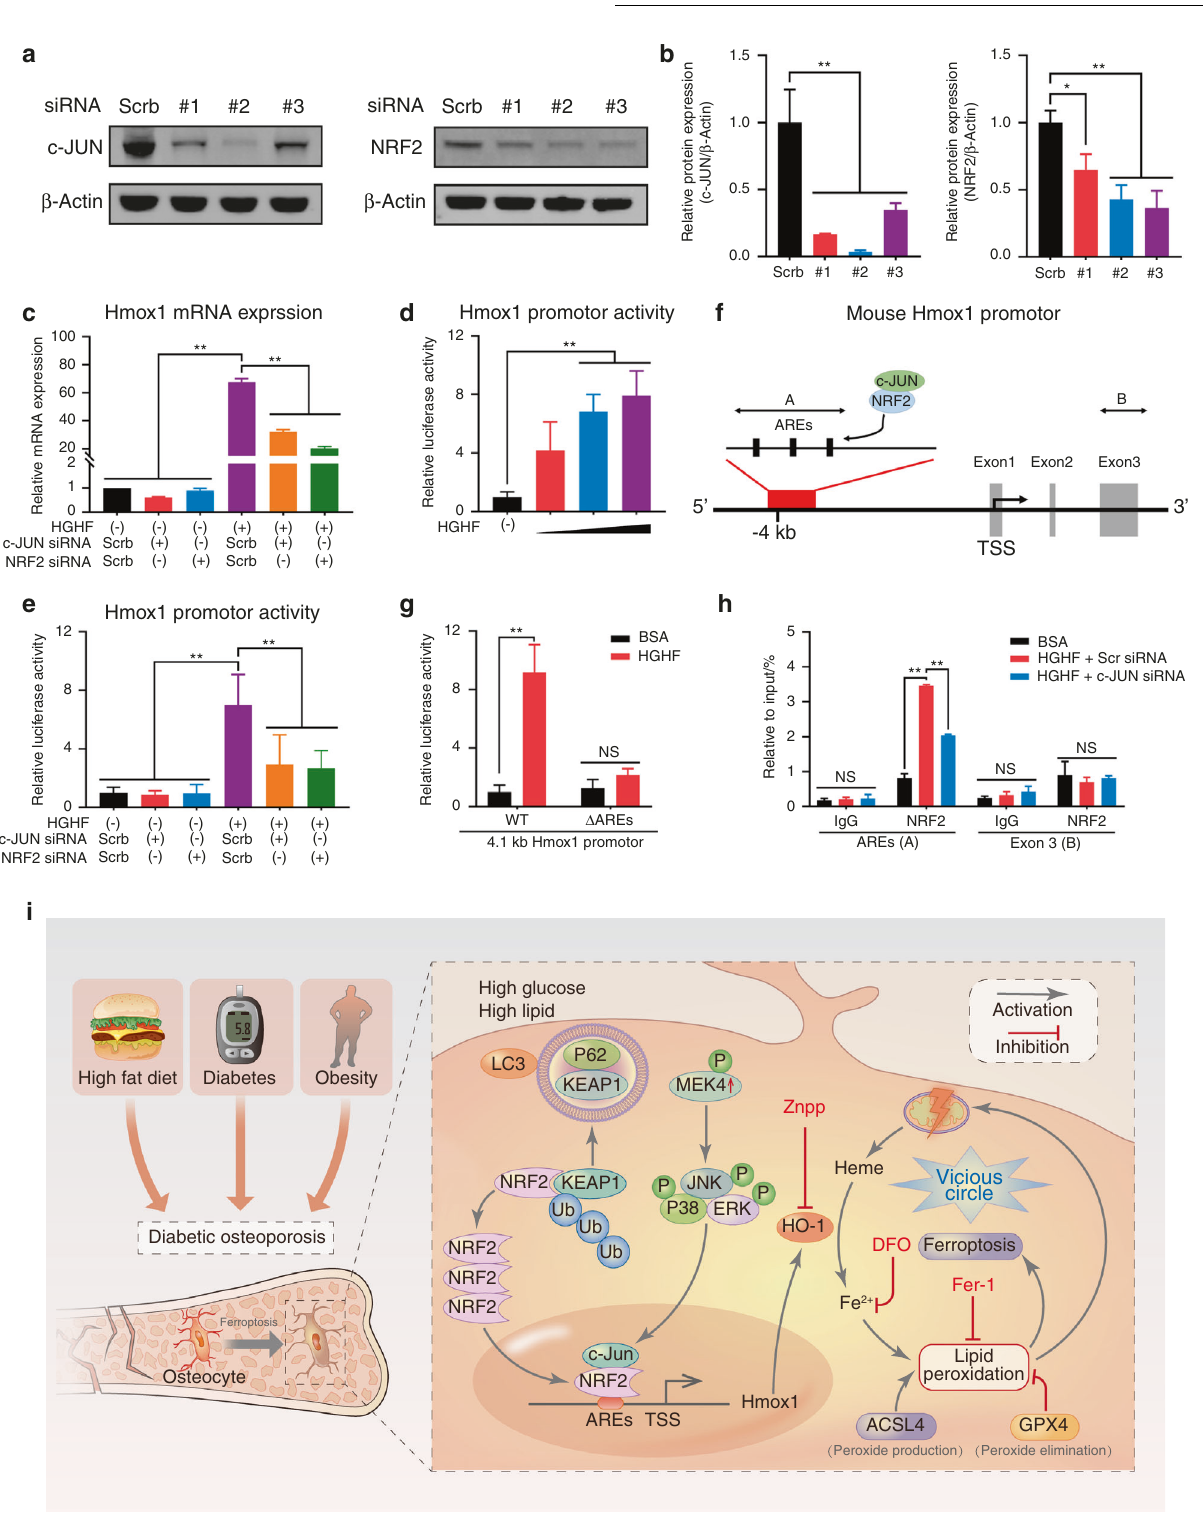
Fig. 6 HGHF-induced HO-1 expression was dependent on the NRF2 – c-JUN interaction. HGHF-induced HO-1 expression was dependent on the NRF2 – c-JUN interaction. a WB results for osteocytes transfected with the indicated siRNA or scrambled siRNA. b Semiquantitative analysis of WB results. c Hmox1 mRNA expression under the indicated treatments was determined using RT – qPCR. d Hmox1 promoter activity under treatment with various concentrations of HGHF was assessed using a dual-luciferase reporter assay. e Hmox1 promoter activity under the indicated treatments was assessed using a dual-luciferase reporter assay. f Schematic representation of the mouse Hmox1 promoter region, including the AREs. g Osteocytes were transfected with the − 4 100/ + 50 promoter construct (WT) or a mutant − 3 900/ + 50 construct (with deletion of the AREs, Δ AREs), and Hmox1 promoter activity was assessed using a dual-luciferase reporter assay. h Osteocytes were treated as indicated for 24 h, and ChIP assays were performed with an anti-NRF2 antibody or normal IgG to detect AREs. i Schematic illustration of the proposed molecular mechanism underlying osteocyte ferroptosis in DOP. HGHF-induced HO-1 expression was dependent on the NRF2 – c-JUN interaction. * P < 0.05; ** P < 0.01. “ NS ” indicates nonsigni fi cant. All data are from n = 3 independent